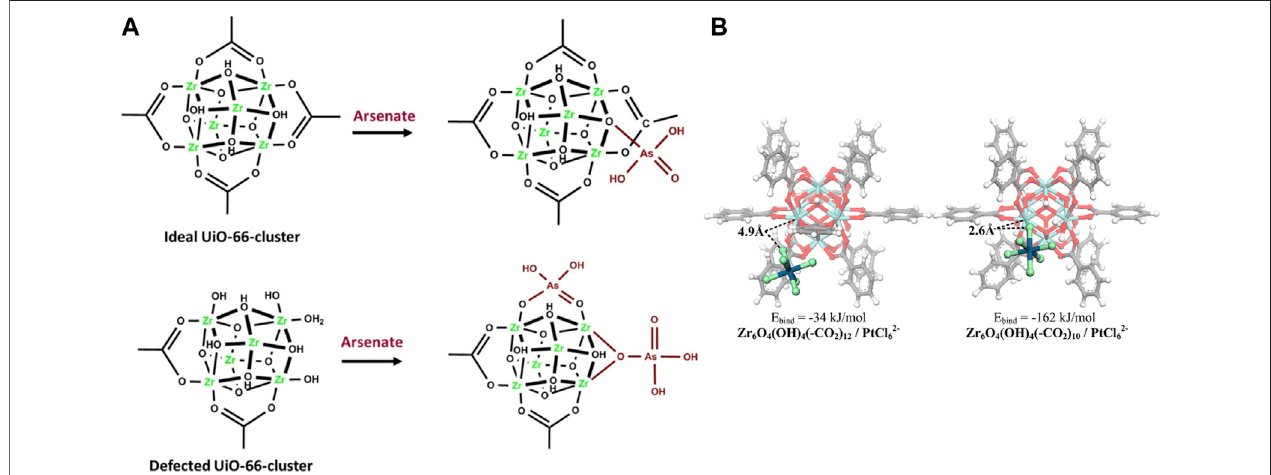
FIGURE7| Possiblemodeofadsorptionof (A) arsenateontheidealzirconiumandthedefectedones(Assaadetal.,2020)and (B) Pt(IV)sorption(Linetal.,2019).